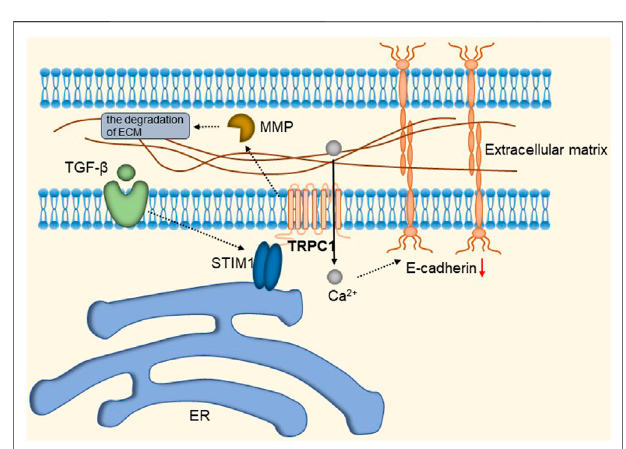
FIGURE 9 | TRPC1-STIM1 complex mediates TGF- β -induced EMT. STIM1 aggregates to the endoplasmic reticulum-plasma membrane (ER-PM) junctions, forming the TRPC1-STIM1 complex with TRPC1, mediating the down-regulation of E-cadherin and leading to the activation of calproteinases and MMPs, which target proteins involved in cell adhesion and promote their migration.